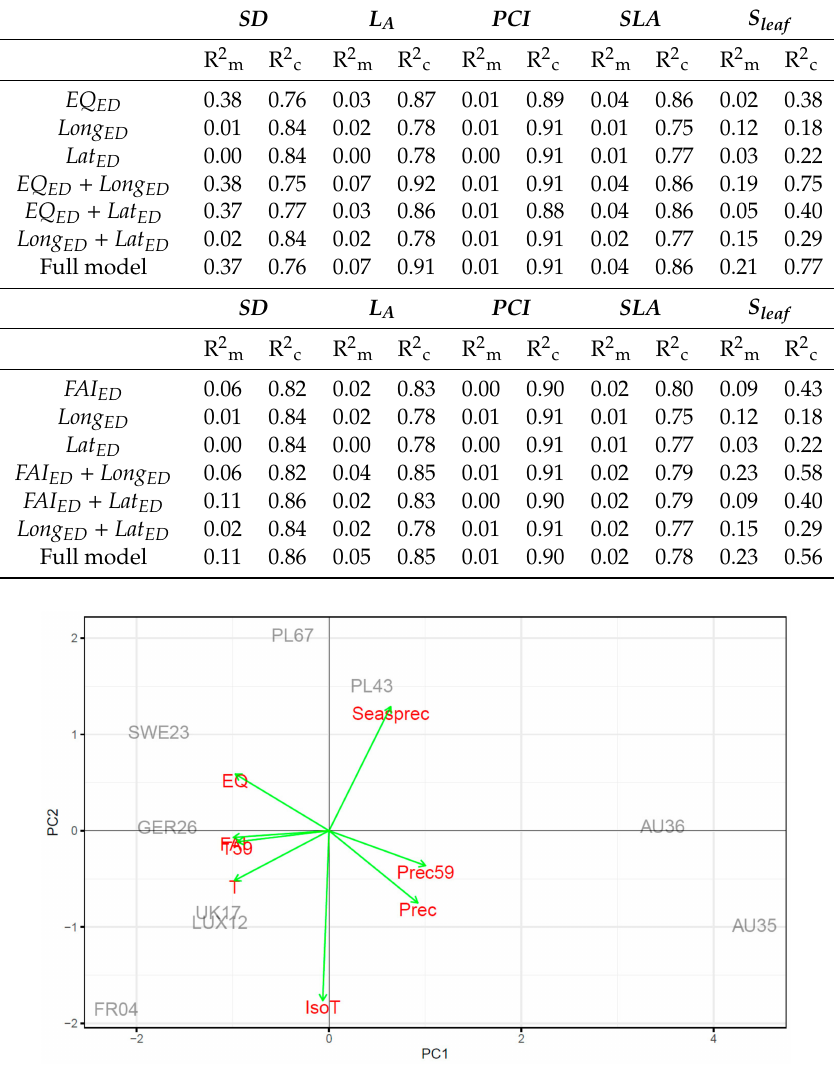
Figure A1. The principal component analysis biplot of provenance’s original